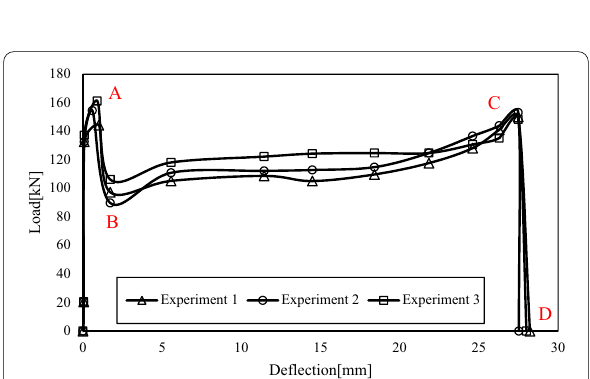
Fig. 16 Load–deflection diagram of sleeper-included positive bending moment of the midspan.